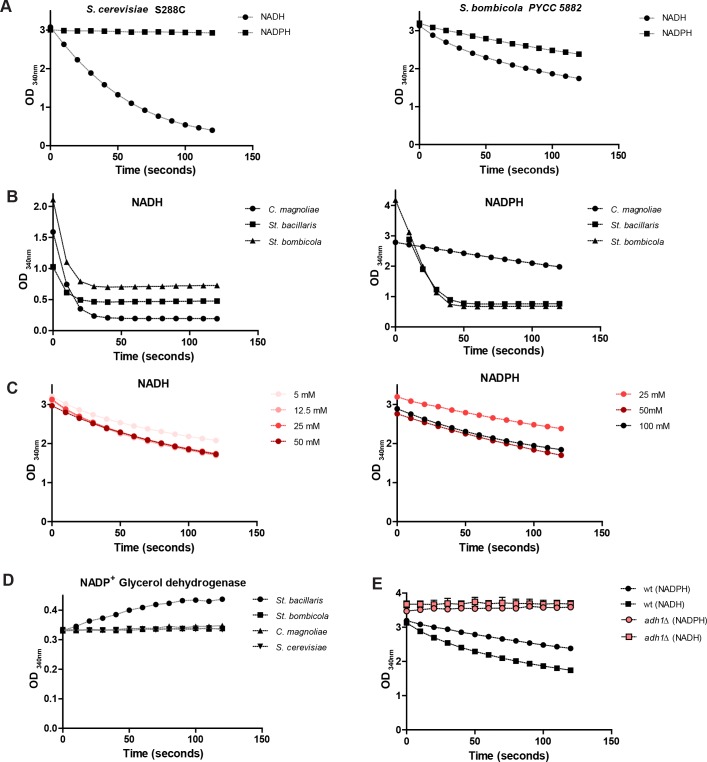
Alcohol dehydrogenase (Adh) activities.